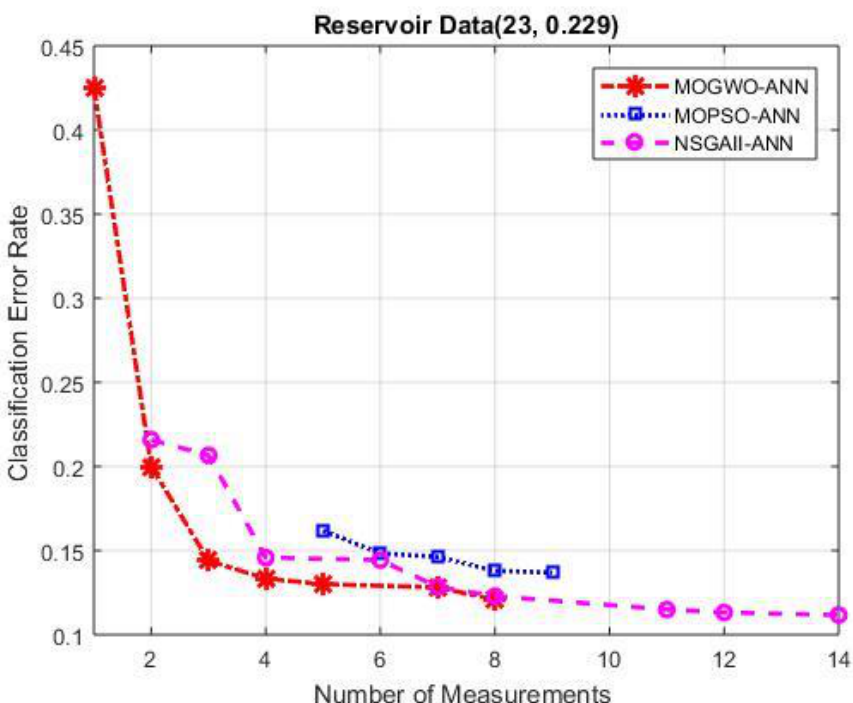
Figure 6. Comparison between MOGWO-ANN, MOPSO-ANN and NSGAII-ANN.